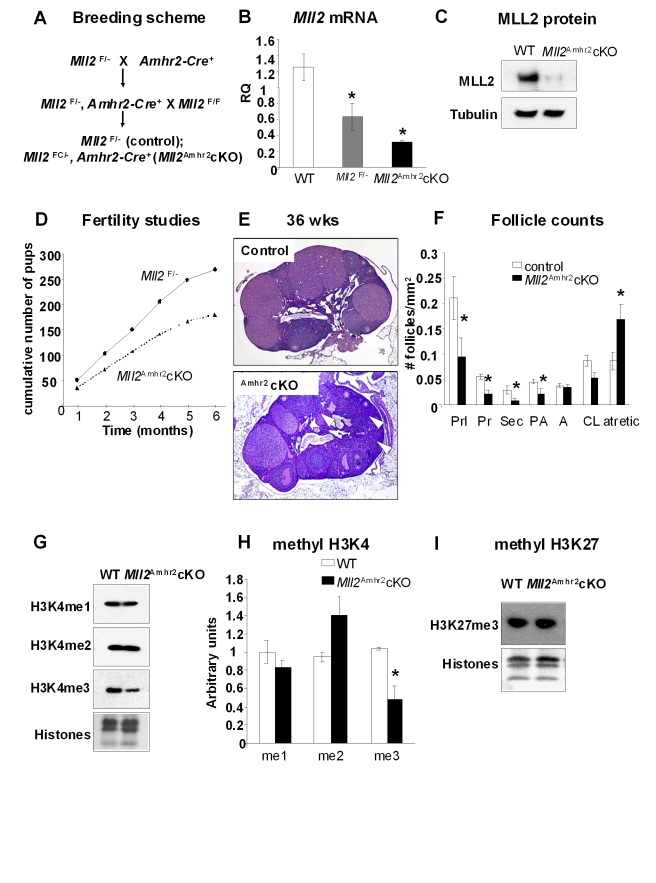
MLL2 is not required for granulosa cell function.(A) Breeding scheme used to generate granulosa cell-specific cKO mice (Mll2Amhr2 cKO). (B) QPCR analysis of Mll2 levels in granulosa cells from wild type (WT), Mll2F/
− (heterozygous control), and Mll2Amhr2 cKO females (granulosa cells from three individual females were used in the analysis; n = 3). Mll2Amhr2 cKO granulosa cells show a significant decrease in the levels of Mll2, whereas Mll2F/
− granulosa cells show the expected 50% decrease in Mll2 levels (ANOVA test; * p<0.05). Gadpdh was used as internal control. (C) Western blot analysis of Mll2Amhr2 cKO granulosa cells showed decreased MLL2 protein levels. Tubulin was used as loading control. (D) Fertility studies shown as cumulative number of pups over a 6-mo period. Mll2Amhr2 cKO females displayed a small reduction in the number of pups (n = 10). (E) PAS-stained ovaries from 36-wk-old Mll2Amhr2 cKO mice showed PAS-positive zona pellucida remnants (oocyte remnants, arrowheads). Note that the number of follicles present at this age is higher than that observed in the oocyte-specific cKO mouse lines. (F) Follicle counts in 36-wk-old ovaries. Mll2Amhr2 cKO ovaries show a significant decrease in the number of quiescent amd growing follicles and a significantly higher number of atretic follicles (ovarian sections from five females were used in this study; n = 5). Abbreviations: Prl, primordial; Pr, primary; Sec, secondary; PA, preantral; A, antral; CL, corpora lutea. ANOVA test; * p<0.05. (G–H) Western blot analysis of H3K4 methylation in chromatin fractions from granulosa cells. (G) Representative micrographs of Western blots showing H3K4me1, H3K4me2, and H3K4me3 levels. (H) Chemoluminescence quantification revealed a significant decrease in global H3K4me3 levels in Mll2Amhr2 cKO granulosa cells (Student's t test, * p<0.05). Means ± S.E are shown. Granulosa cells from three individual females per genotype were used in three independent experiments; samples were normalized against total histones. (G) Representative Western blot analysis of the repressive mark H3K27me3 showed no global changes in Mll2Amhr2 cKO granulosa cells. Total histones were used as internal loading control.